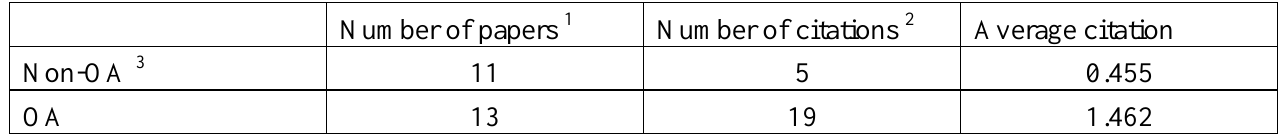
Table 2. Open Access (OA) and non-Open Access (non-OA) papers published in International Journal of Molecular Sciences in 2005